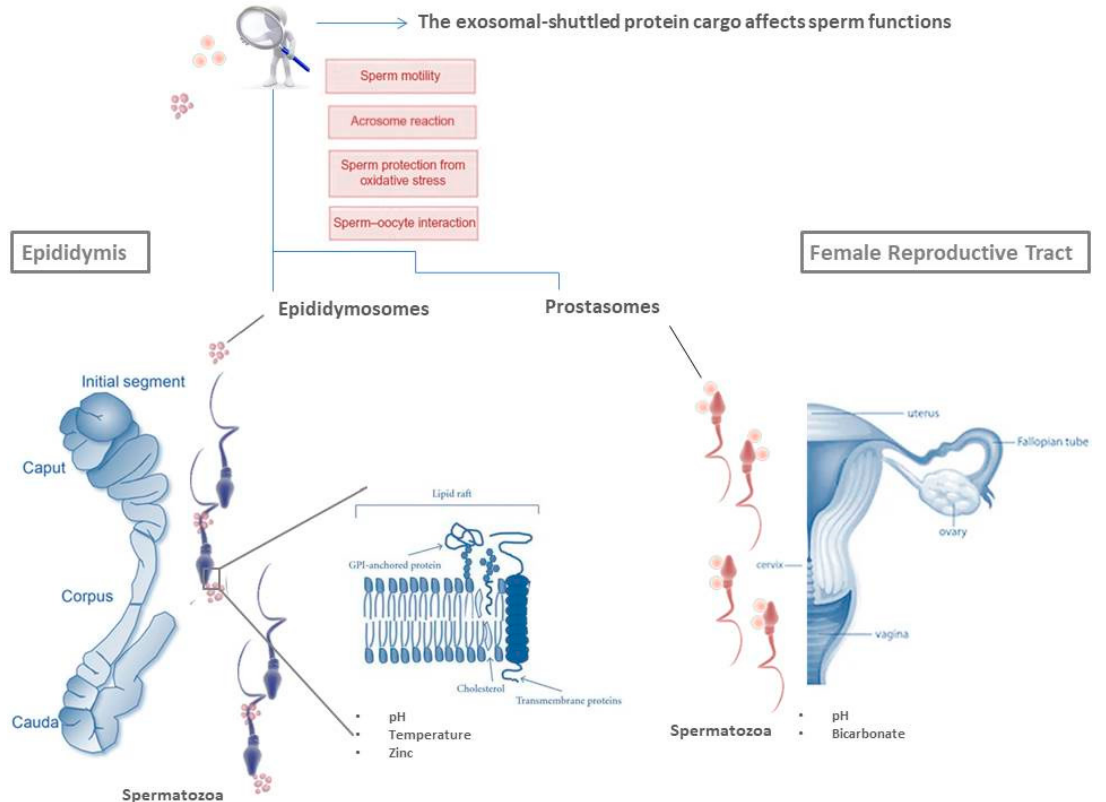
Figure 1. The fate of spermatozoa (SPZ) beyond testis. During their transit along the epididymis, SPZ receive proteins carried by epididymosomes. The GPI-anchor-mediated docking is a way of epididymosomal delivery cargo from lipid rafts of epididymosomes to lipid rafts of SPZ. Other conditions, such as pH, temperature and zinc concentration surely influence vesicle fusion. During ejaculation, SPZ encounter another subset of exosomes: the prostasomes. The recruitment of prostasomes by SPZ requires the presence of bicarbonate and an environment with a favorable pH. Proteins shuttled via exosomes are involved in important sperm functions such as sperm motility, prevention of premature acrosome reaction, protection of SPZ from oxidative stress and sperm–oocyte interaction.